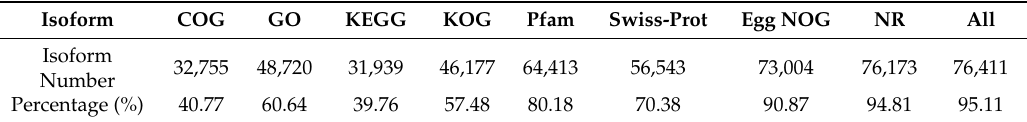
Figure 2. Homologous species distribution of Pinus elliottii annotated from the NR (NCBI nonredundant protein sequences) database. Table 1. Functional annotation of P. elliottii ’s full-length transcriptome. This table shows the number of high-quality isoforms that were blasted to public databases, including COG (Clusters of Orthologous Groups) [19], GO (Gene Ontology) [20], KEGG (Kyoto Encyclopedia of Genes and Genomes) [21], KOG (euKaryotic Ortholog Groups) [22], Pfam (Protein family) [23], Swissprot [24], EggNOG (Evolutionary genealogy of genes: Non-supervised Orthologous Groups) [25], and NR (NCBI nonredundant protein sequences)